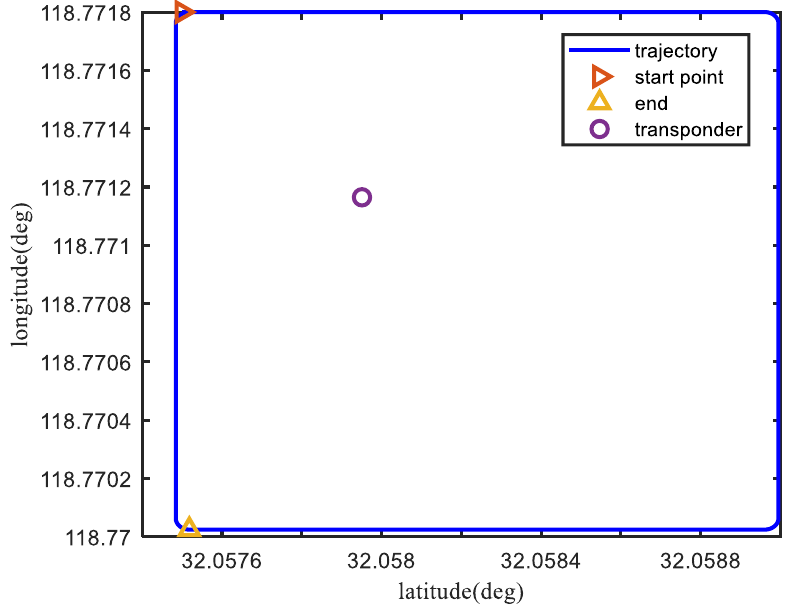
Figure 3. The AUV simulation trajectory.